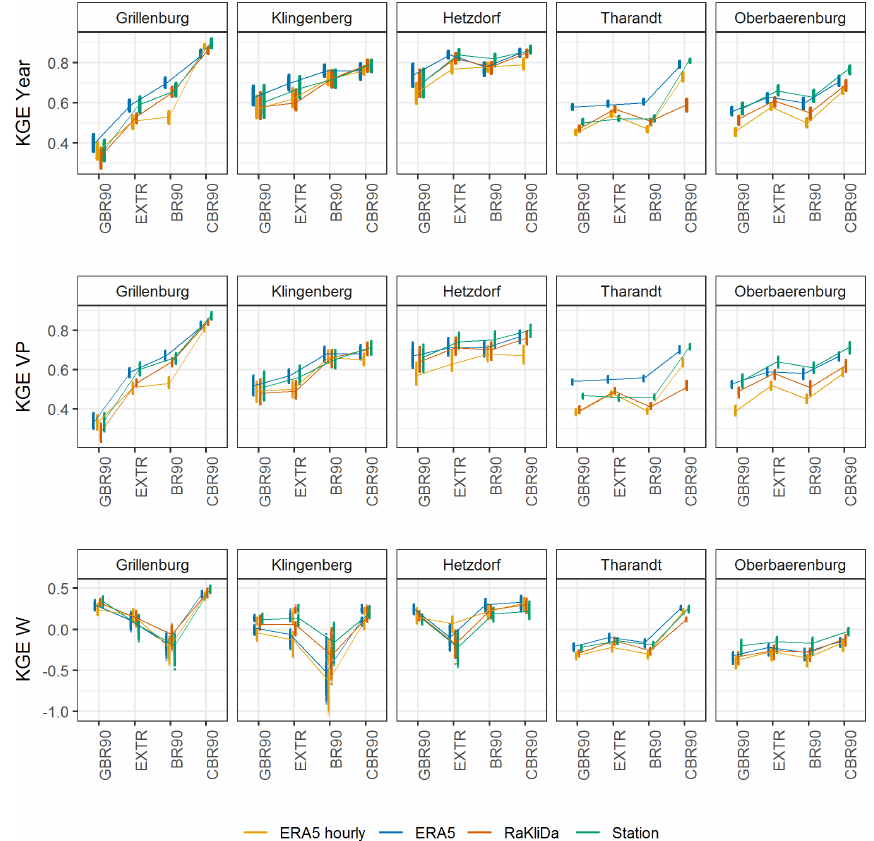
Figure 5. KGE values for daily evaporation: whole year, vegetation and winter periods. Vertical lines for each cross-combination refer to bootstrapped